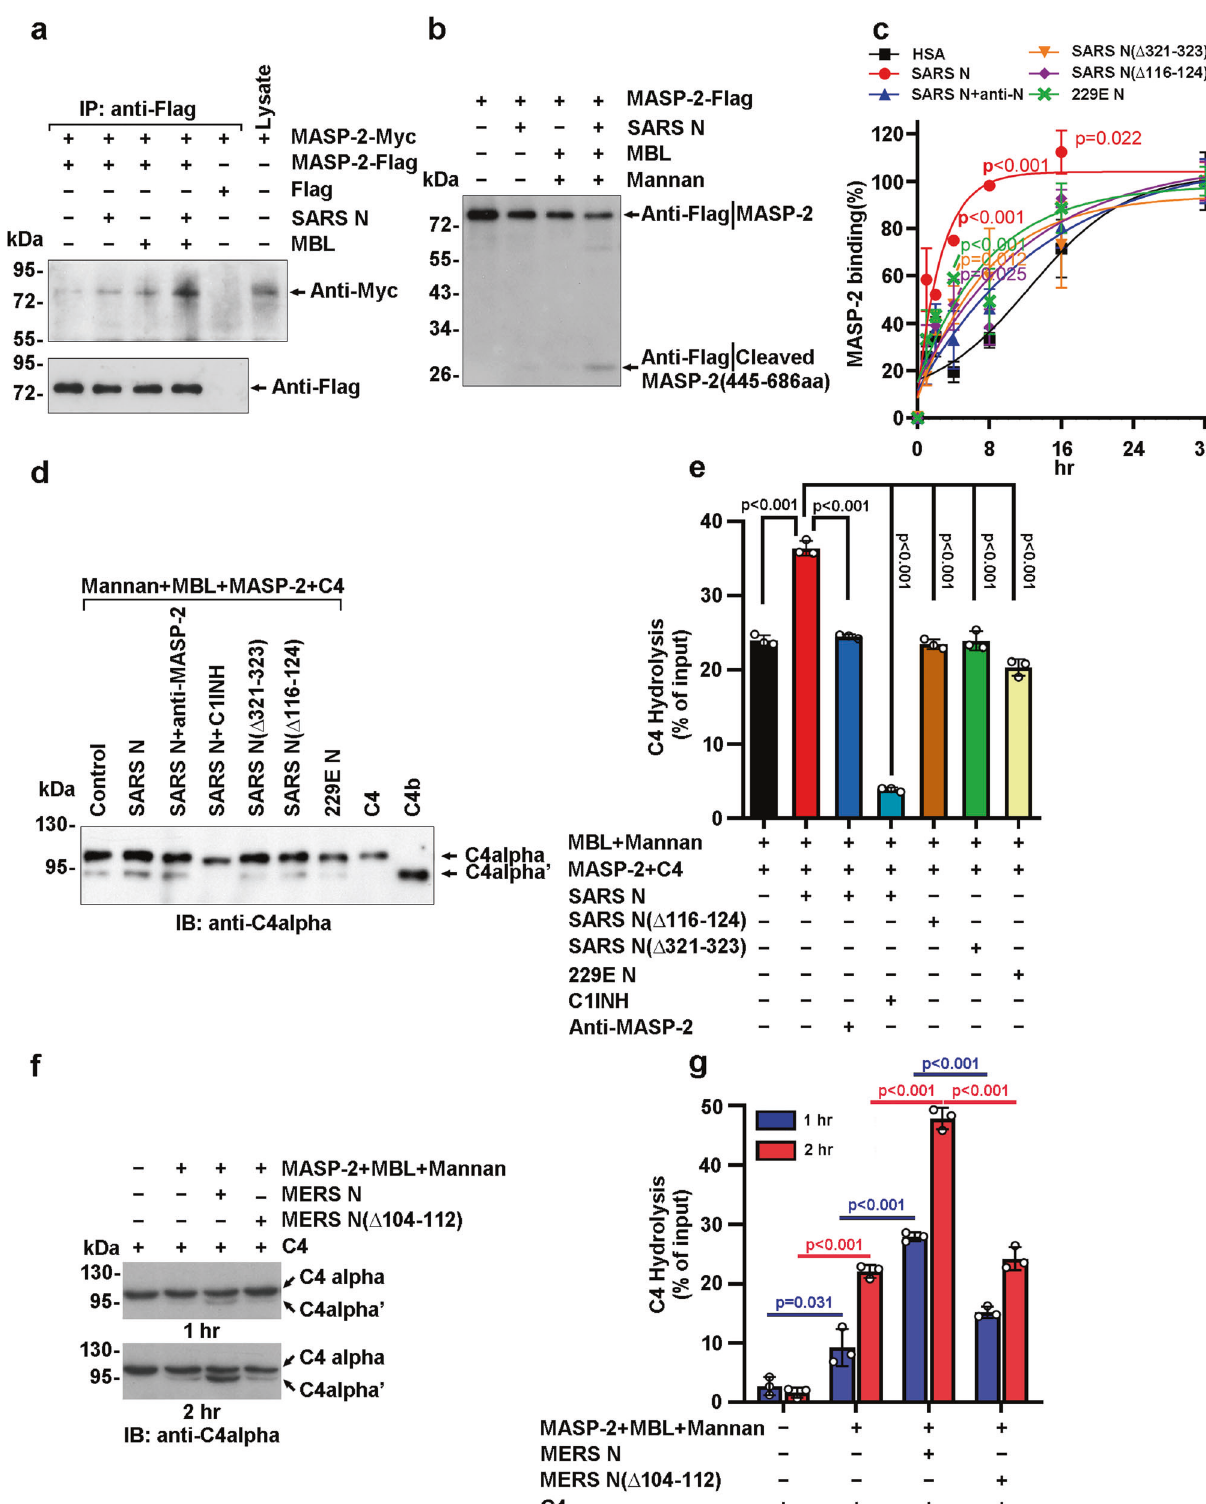
these results suggest that suppression of MASP-2-mediated complement overactivation may provide an approach for the treatment of pneumonia in pathogenic coronavirus-infected patients.